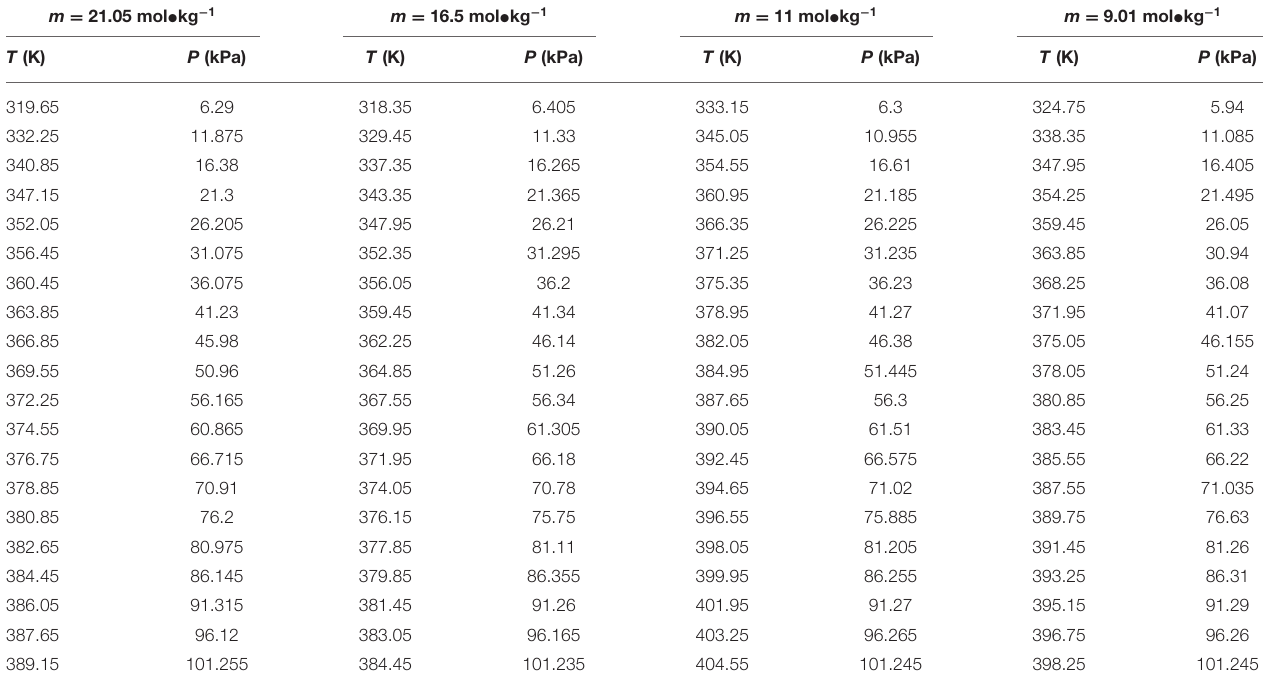
TABLE 2 | Experimental VLE data for temperature T , pressure P , and molality m— LiBr for the LiBr + H 2 O